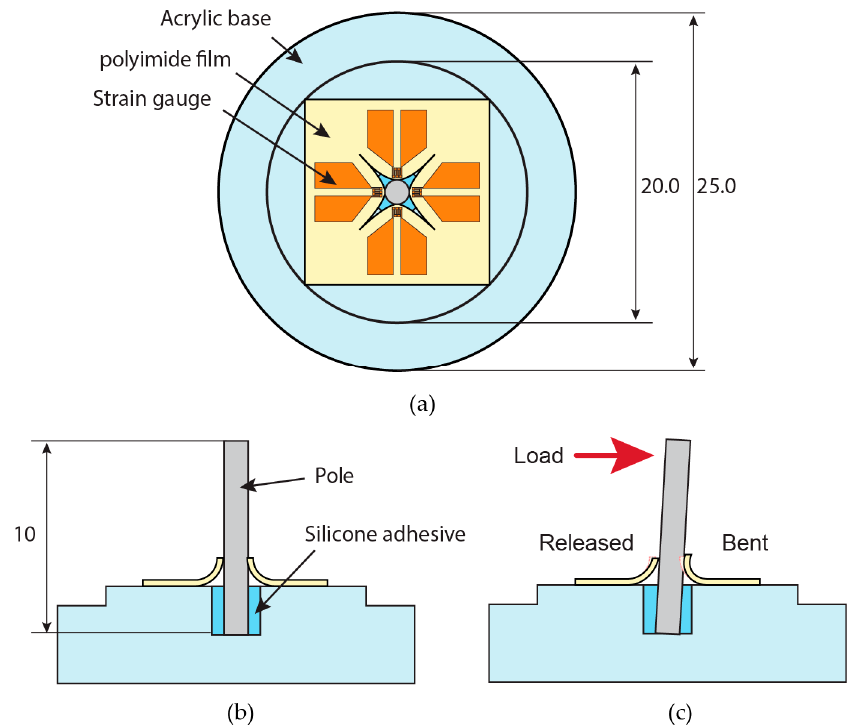
Figure 2. ( a ) Design of the proposed device, top view (above) and ( b ) cross-sectional side view (below). All dimensions are in mm. ( c ) When the load is applied to the pole, one side of the strain gauge is released and the one on the other side is bent.